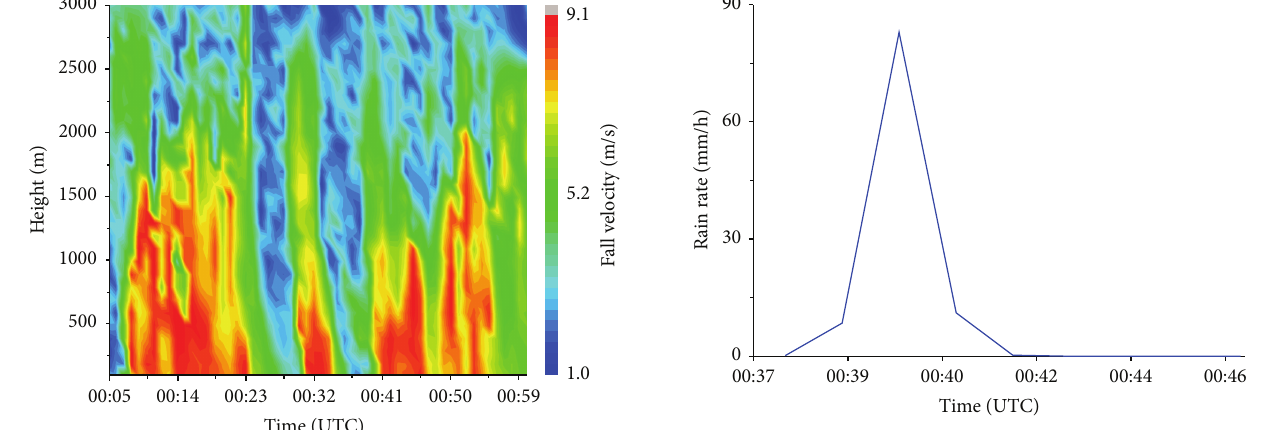
Figure 9: Evolution of the rain rate in a transverse slice at a height of 2,200 m.